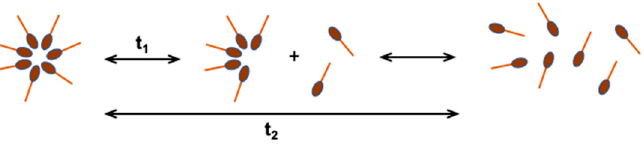
Figure 3. Dynamic equilibrium of micelles with monomers in aqueous solution; t 1 —fast relaxation time, in the order of microseconds, t 2 —slow relaxation time, in the order of milliseconds [20].